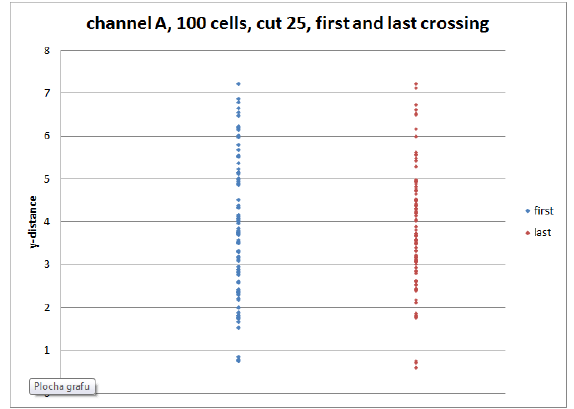
Fig. 8. For 100 cell in channel A and cutting position 25 + k.100 μm two datasets of distances for first and last crossing are depicted. The difference in their distribution is not clear visible